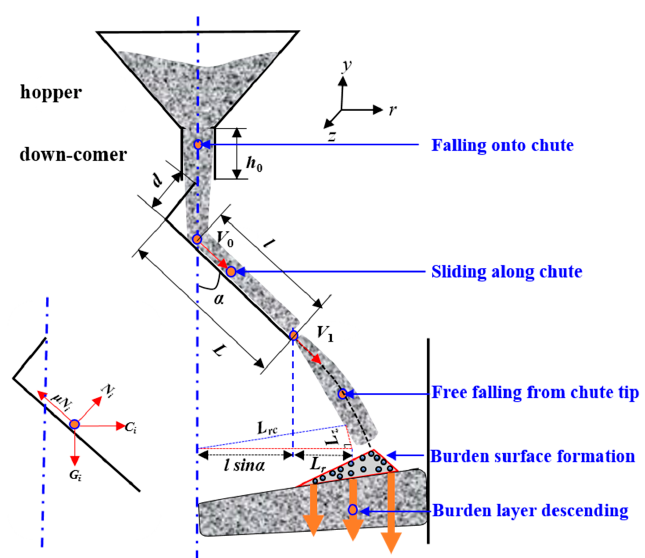
Figure 1. Schematic illustration of the steps considered in the burden distribution model.